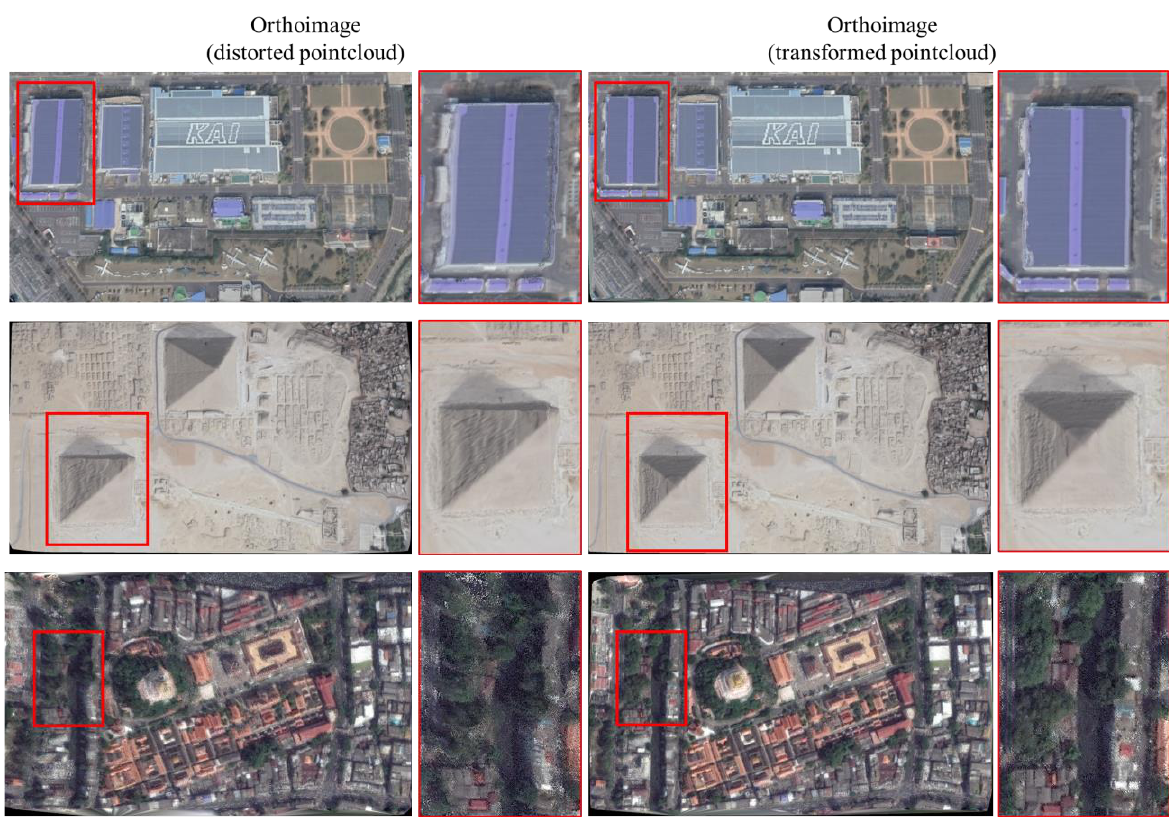
Figure 6 . The comparison of generated orthoimage. Left images are the orthoimages using the distorted point cloud. It has still facade regions, similar to the GE satellite image. Instead, the right images show that more correctly orthoimage is generated (especially building, pyramid, and tower). It means that the 3D homography-based projective reconstruction can generate the correct shape of the 3D surface of an orthographic projection model